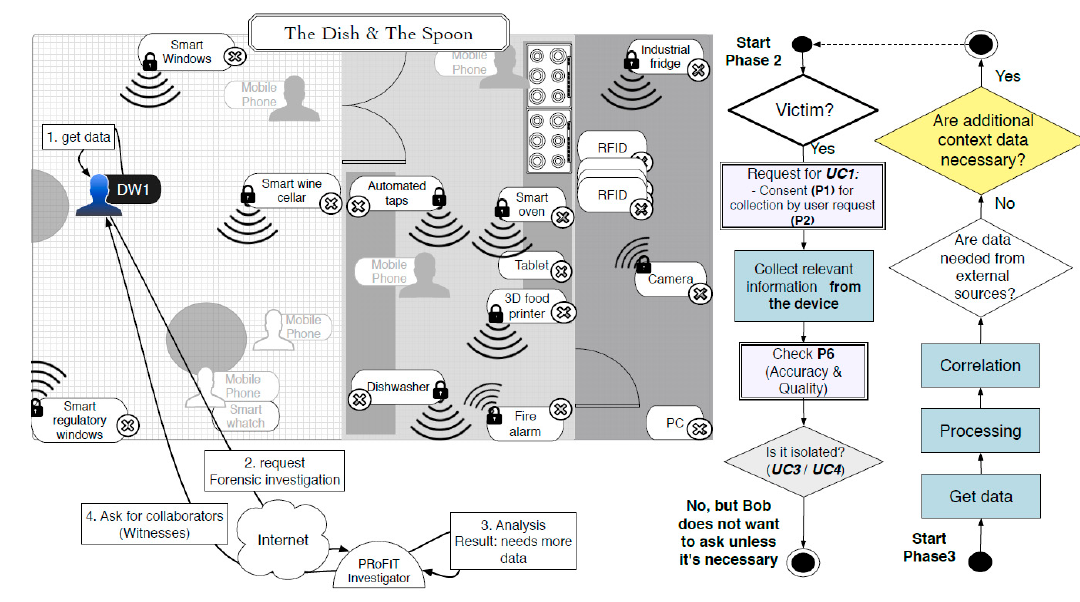
Figure 7. Request the start of digital